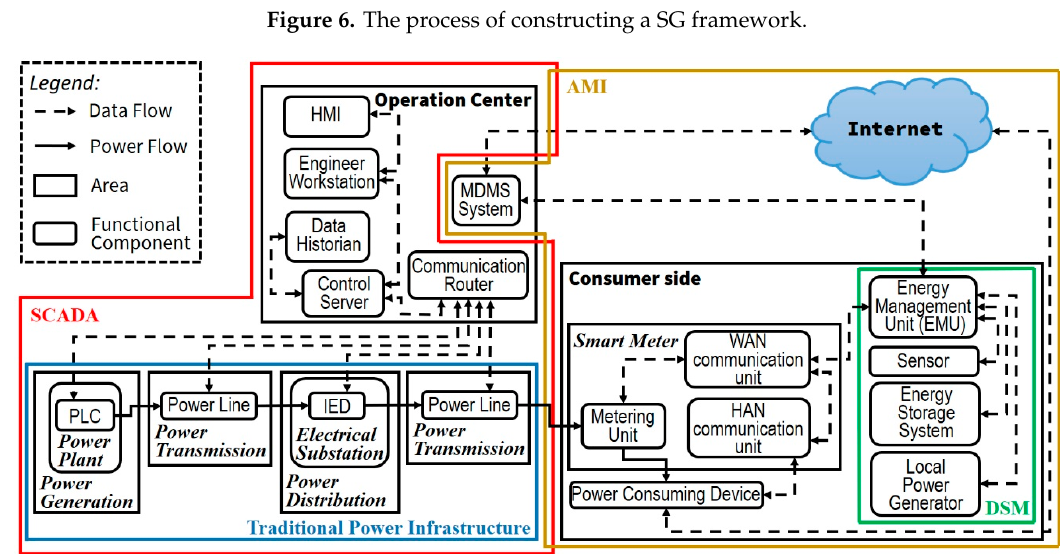
Figure 7. The suggested SG framework.